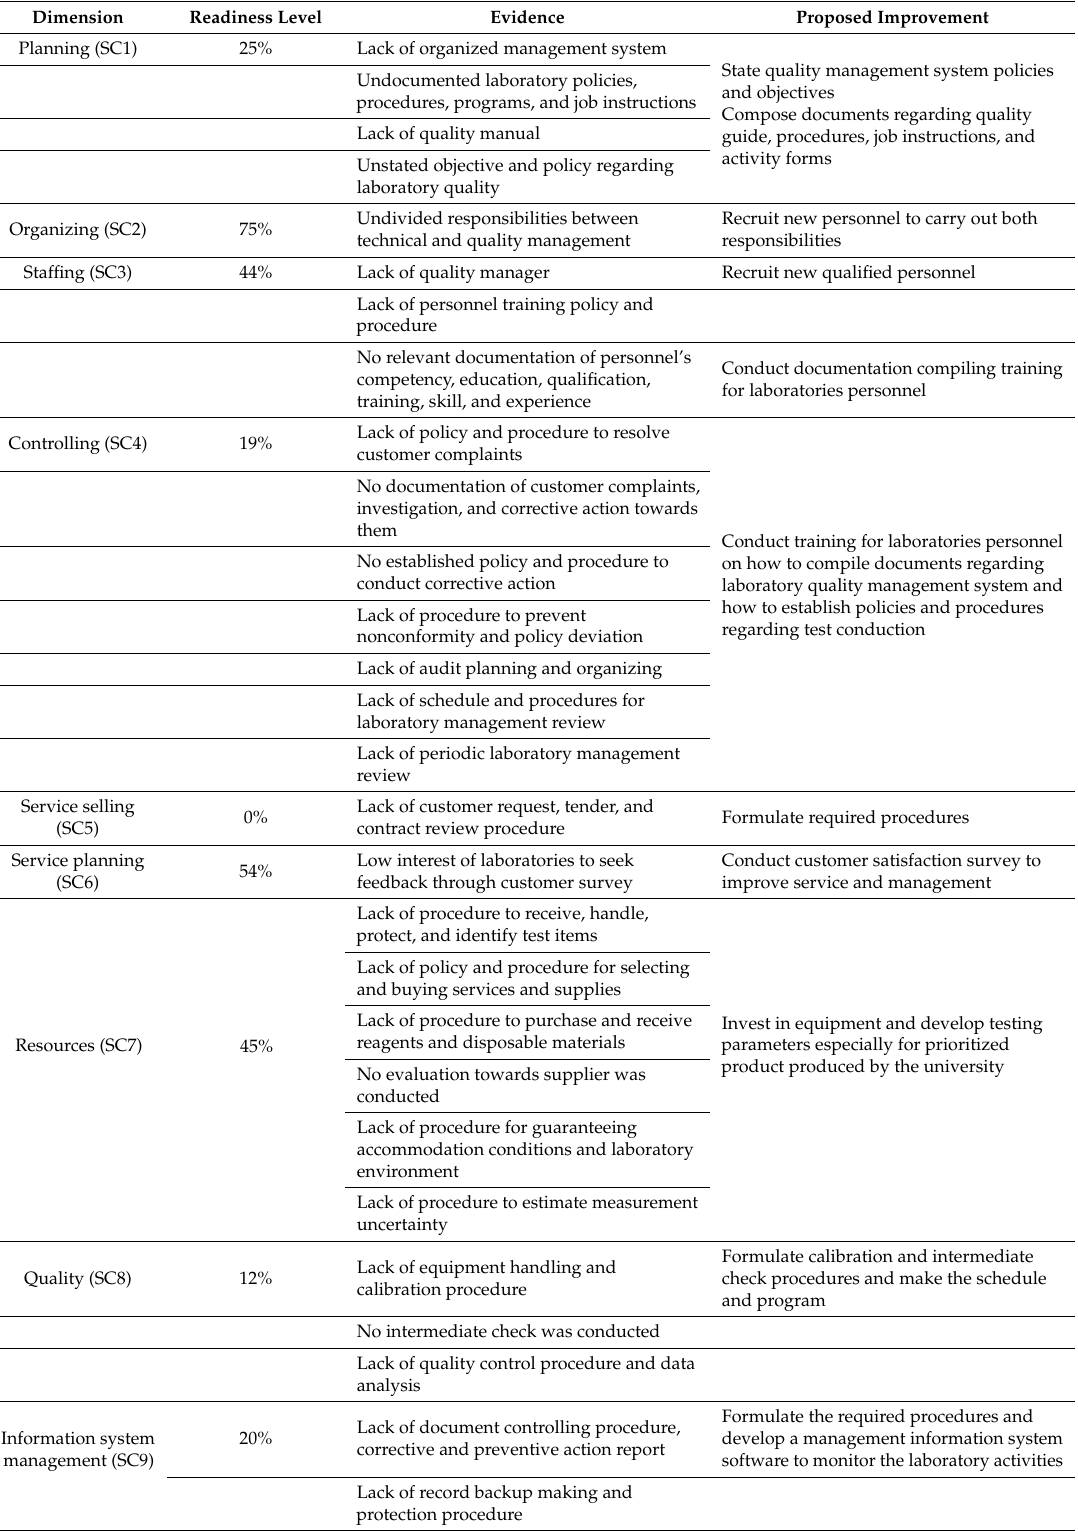
Table 6. Existing evidence and proposed